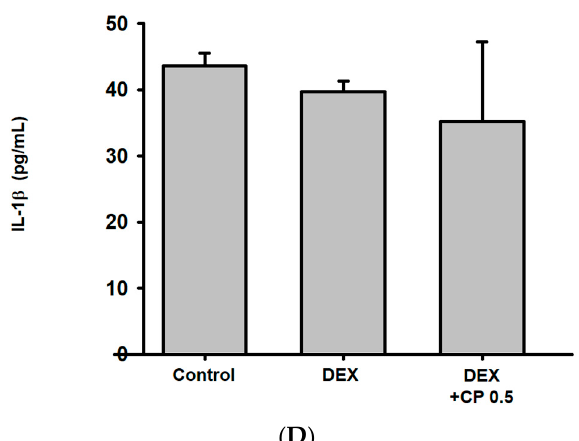
Figure 5. Anti-inflammatory activity of CP in muscle tissue. ( A ) Evans blue staining of the calf muscle. The blue region in the representative images indicates damaged muscle fibers. The Evans blue-positive area was quantified and is presented as a relative percentage of the control below the representative photos. This experiment was performed with three mice per group. ( B , C ) The mRNA expression of TNF- α and IL-1 β in the muscles was assessed using real-time PCR. Data are presented as the means ± SD of values obtained from seven biological replicates. ( D ) The IL-1 β levels in serum were examined using ELISA. Data are presented as the means ± SD of values obtained from three biological replicates. # p < 0.05, ## p < 0.01, DEX vs. control. # p < 0.05, ## p < 0.01, DEX + CP (0.25 and 0.5) vs. control. * p < 0.05, ** p < 0.01, DEX + CP (0.25 and 0.5) vs. DEX; CP, collagen peptides; DEX,